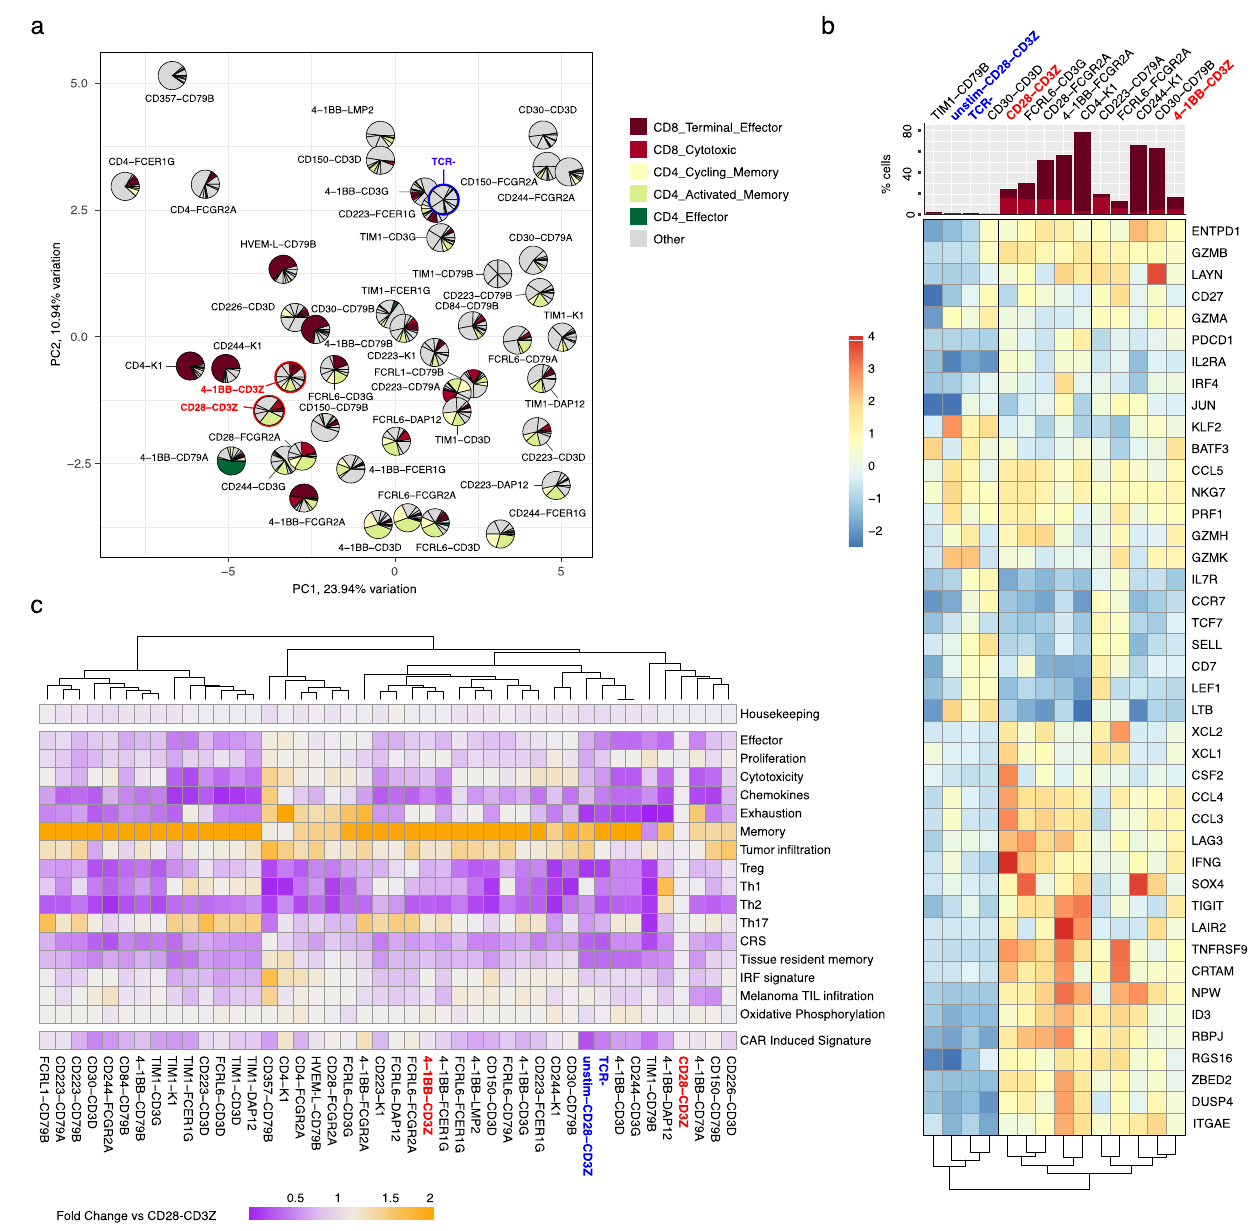
Fig. 3 | Speci fi c gene transcriptional signatures are used to assess CAR T cell functionality. a Principal component analysis (PCA) of pseudo-bulked scRNA-seq datafromthetop40mostrepresentedCARvariantsstudiedinFig.2.Alsoincluded are cells expressing 28z (CD28-CD3Z) and BBz (4-1BB-CD3Z) colored in red and CAR negative T cells (TCR-) colored in blue. To avoid batch effect variation, only datafromDonor3isused.Overlayedovereachdatapoint,piechartsrepresentthe enrichment of cells in CICs from Fig. 2f. b Expression levels of a set of 42T cell marker genes across CD8+pseudo-bulked scRNA-seq samples of a small panel of 10 different CAR T cell variants, 28z and BBz benchmark CAR T cells, TCR- T cells and unstimulated 28z CAR T cells. CAR variants were selected based on their